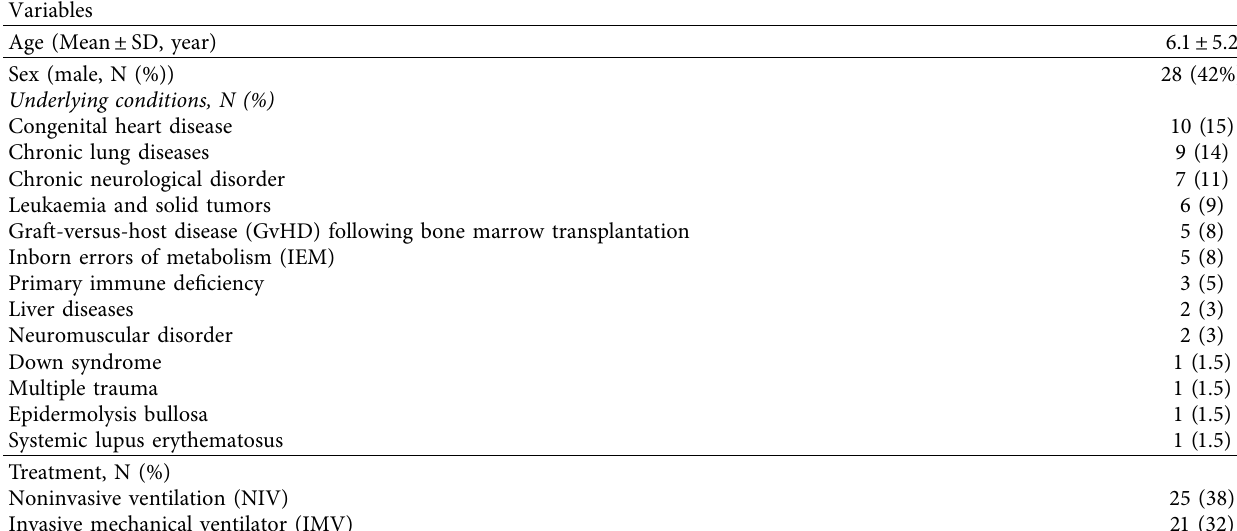
Table 1: The demographic data of 66 patients with positive SARS-CoV-2 RT-PCR.